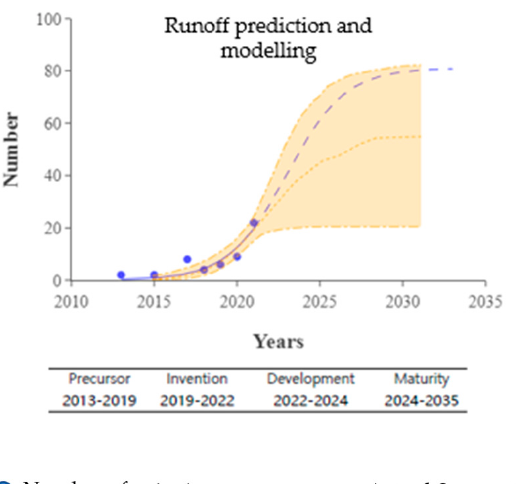
Figure 19. S-curve for runoff prediction and modeling in patents.